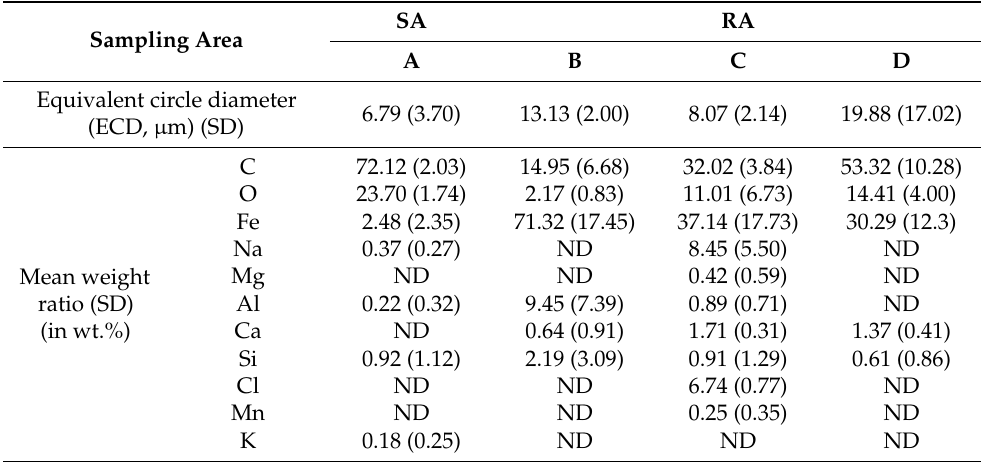
Table 10. Energy-dispersive X-ray spectroscopy analysis of equivalent circle diameters (µm ) and weight ratios (wt%) of typical Fe particles in the supply air (SA) and return air (RA).